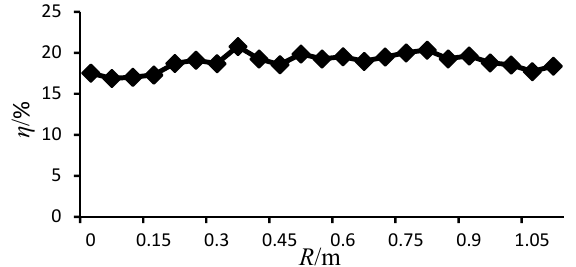
Figure 11. Harvest power curve through varying tip radius of cone.